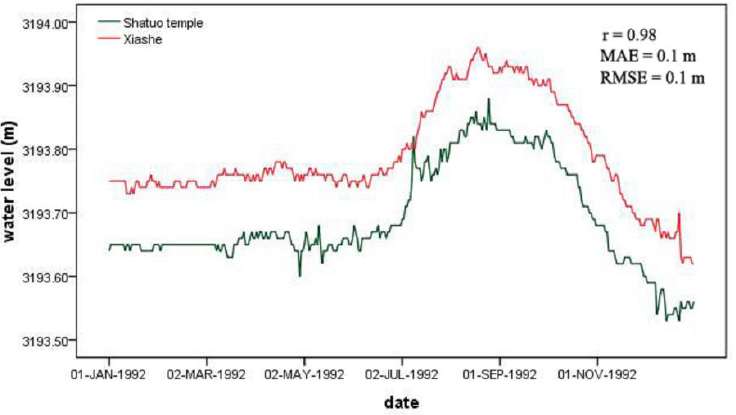
Figure 11. Comparison of the water levels measured at different gauging